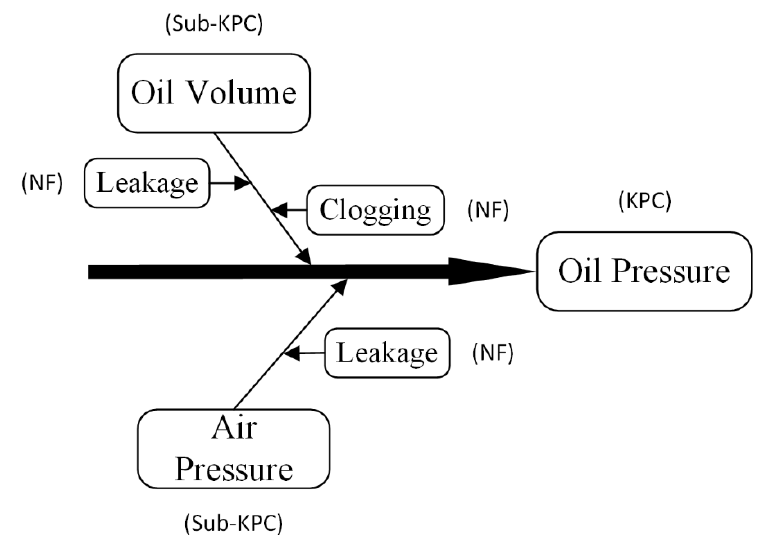
Figure 6. Air-oil accumulator variation transfer Ishikawa diagram.